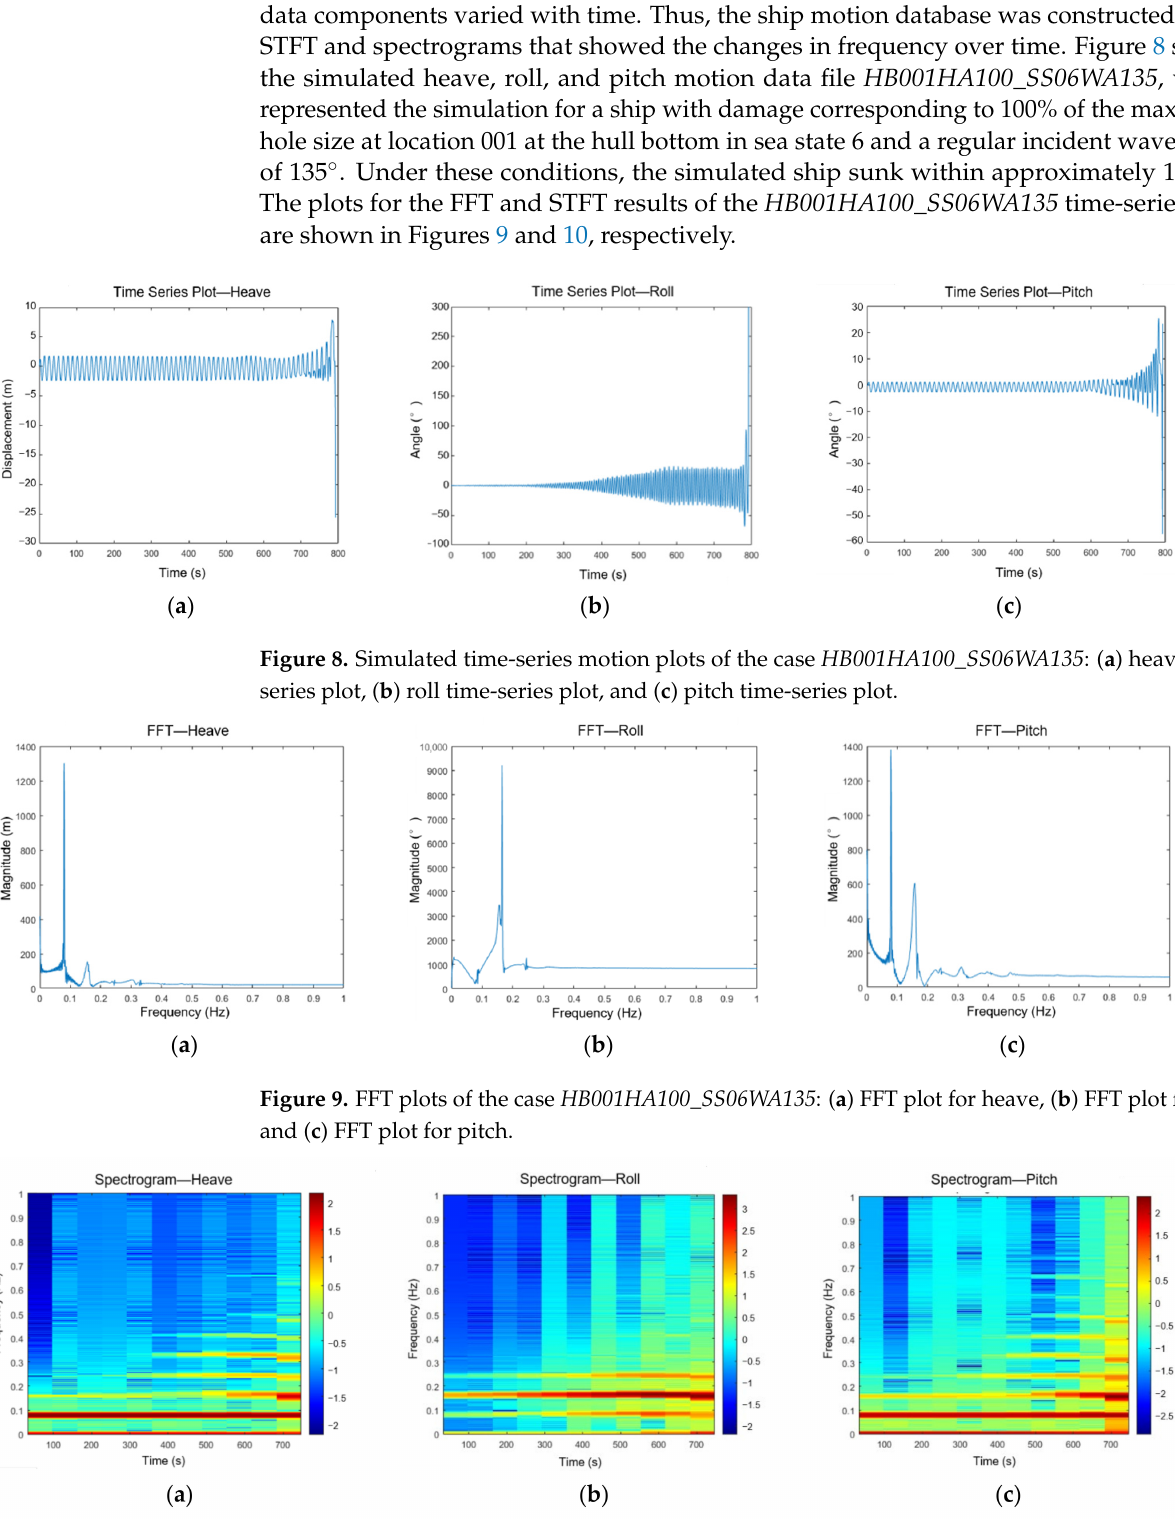
Figure 10. Spectrogram of the case HB001HA100_SS06WA135 : ( a ) spectrogram for heave, ( b ) spectrogram for roll, and ( c ) spectrogram for pitch.